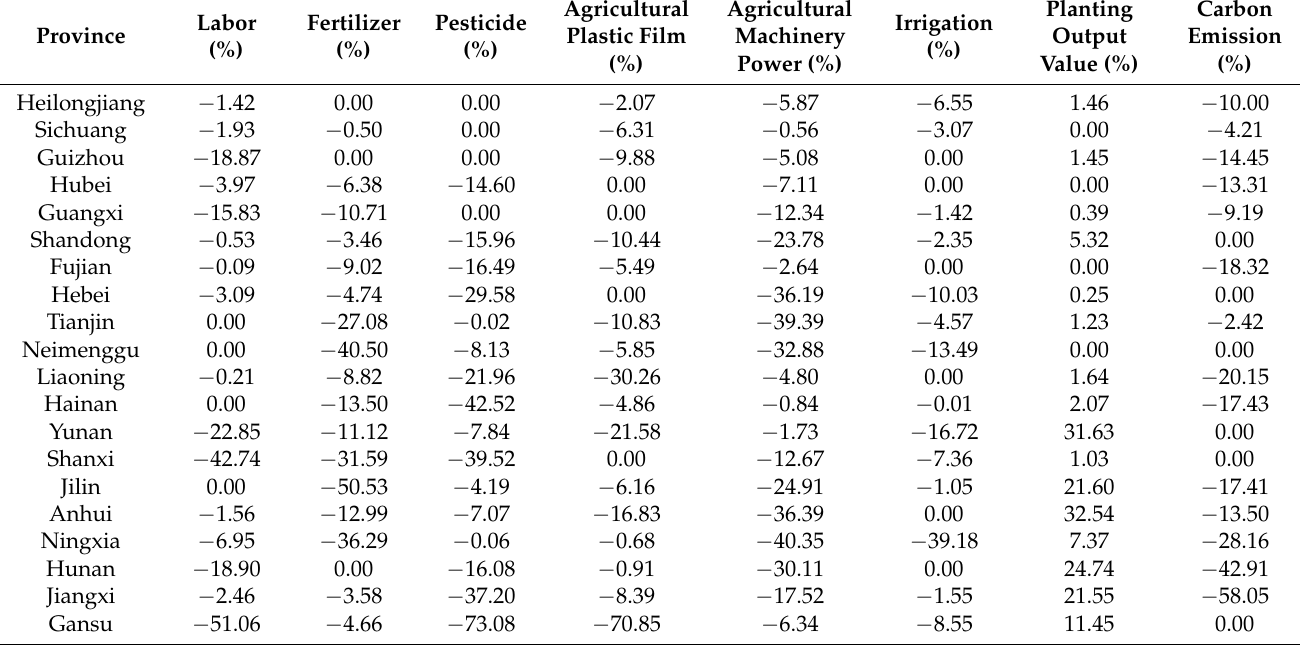
Table 4. Average relaxation improvement ratio of input–output indicators of cultivated land use in